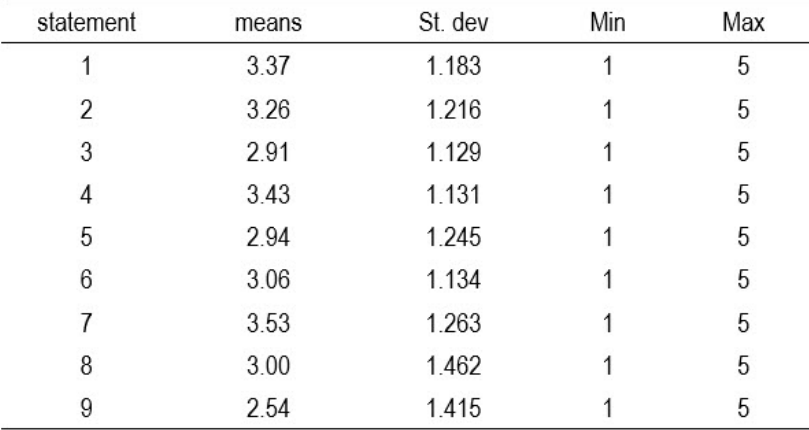
Students’ attitudes towards the faculty image on social